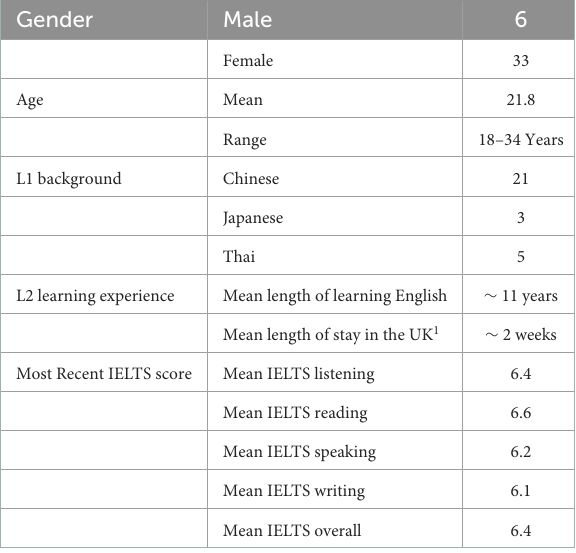
TABLE 2 Participant background